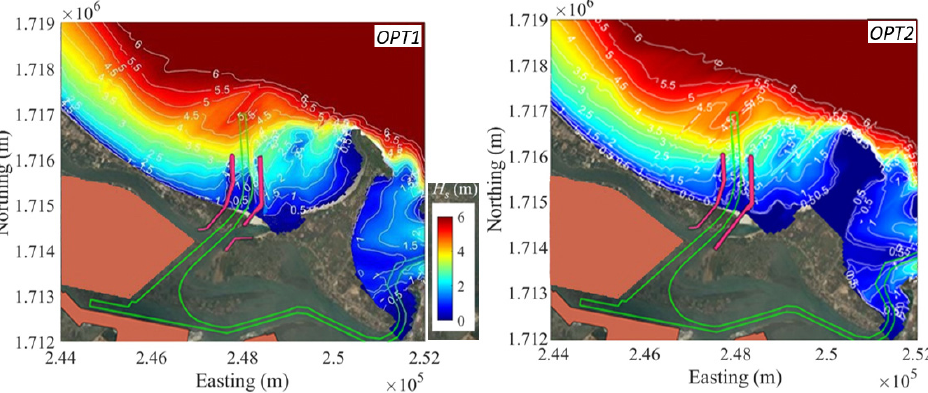
Figure 20. Wave field during typhoon Molave after jetty construction. Figure 21 illustrates the velocity field during typhoon Molave after jetty construction.